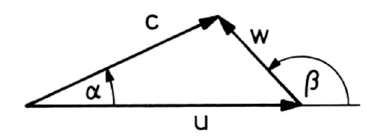
Figure 14. Absolute velocity and angle at impeller exit in the relative frame of reference, point P1. 3.3. Unsteady Analysis at 2M In this section, the results from the transient analysis are discussed to understand the effect of the non-uniform rotating flow pattern coming from the impeller on the vaned diffuser. The analysis is focused on plane 2M for operating point P1 to get a direct comparison with the experimental data. Because of random sampling inherent to the L2F technique and due to the need for a constant time- step in the simulations, there is a minor shift between numerical and experimental instants (with absolute errors between 0.1% and 2.6%). The analysis is performed using the same rotor-stator positions from measurements. Figures 15 and 16 are diffuser-sided views in the absolute frame of reference: the impeller moves from right to left. The numerical results have been obtained from the transient simulation approach HR-KO discussed in the previous section. A good matching between the numerical and the experimental data can be observed with very similar flow patterns. The main difference takes place in the velocity distribution at the unsteady position φ ID / φ tI = 0.595. At that instant, experimental results show a high velocity zone extending clearly from right to left along the front wall and spreading towards the rear wall; this stretching is not completely detected with the numerical simulation. On the other hand, a velocity pattern similar to the experimental data has been obtained for the two transient simulations using the SST model for the operating points M and P1. Nevertheless, in the operating point P1, the results with SST are shifted because of the stall appearing downstream in the diffuser channel, so consequently the flow is slower and more tangential at plane 2M. The results using the SST model are not used for further discussion because of the instability produced by the stalled channel in the diffuser, as previously discussed.